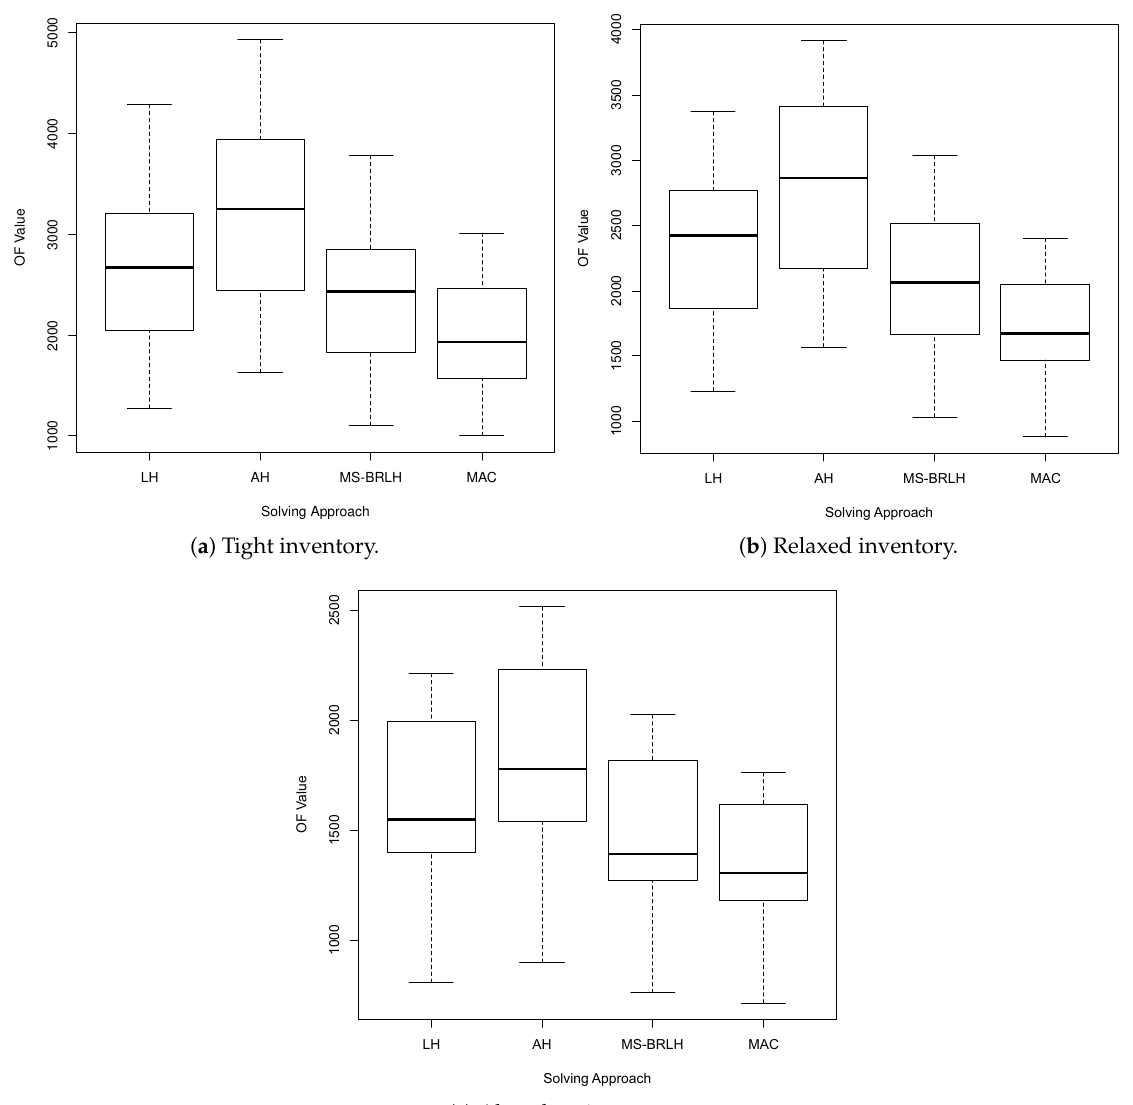
Figure 5. Comparison of the solutions cost (OF value) from each solving approach, for each inventory